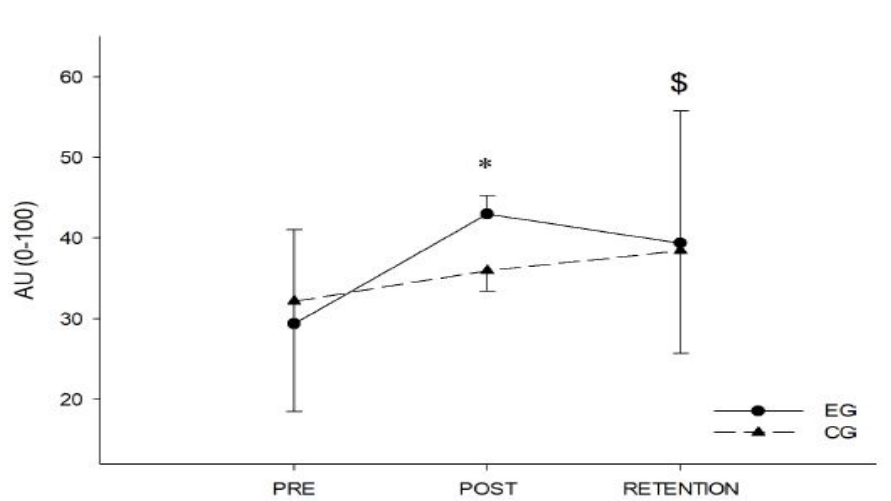
Figure 2. Index of motor efficiency analysis in the pre-post and retention phases. * = significant p -value (<0.05) in between groups analysis (EG vs. CG); $ = significant p -value (<0.05) in within EG analysis (pre vs. post vs. retention).